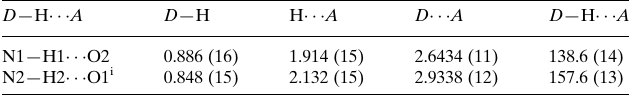
Hydrogen-bond geometry (A ˚ , (cid:2)